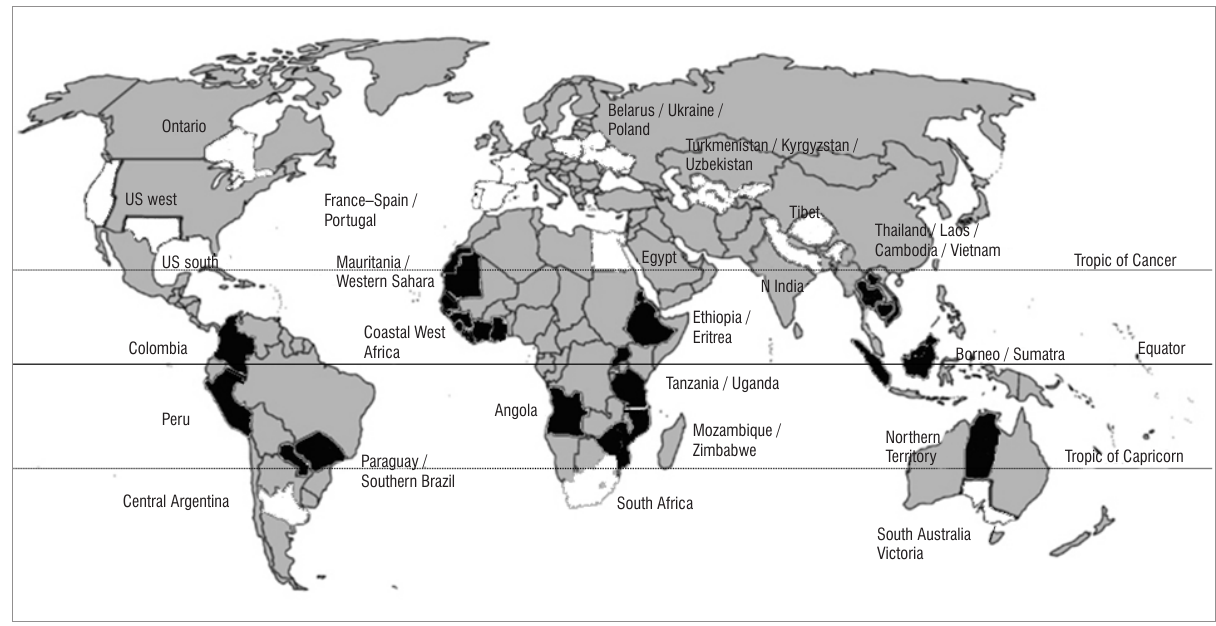
Figure 2: Schematic world map highlighting the 24 regions studied (black = tropical; white = temperate).